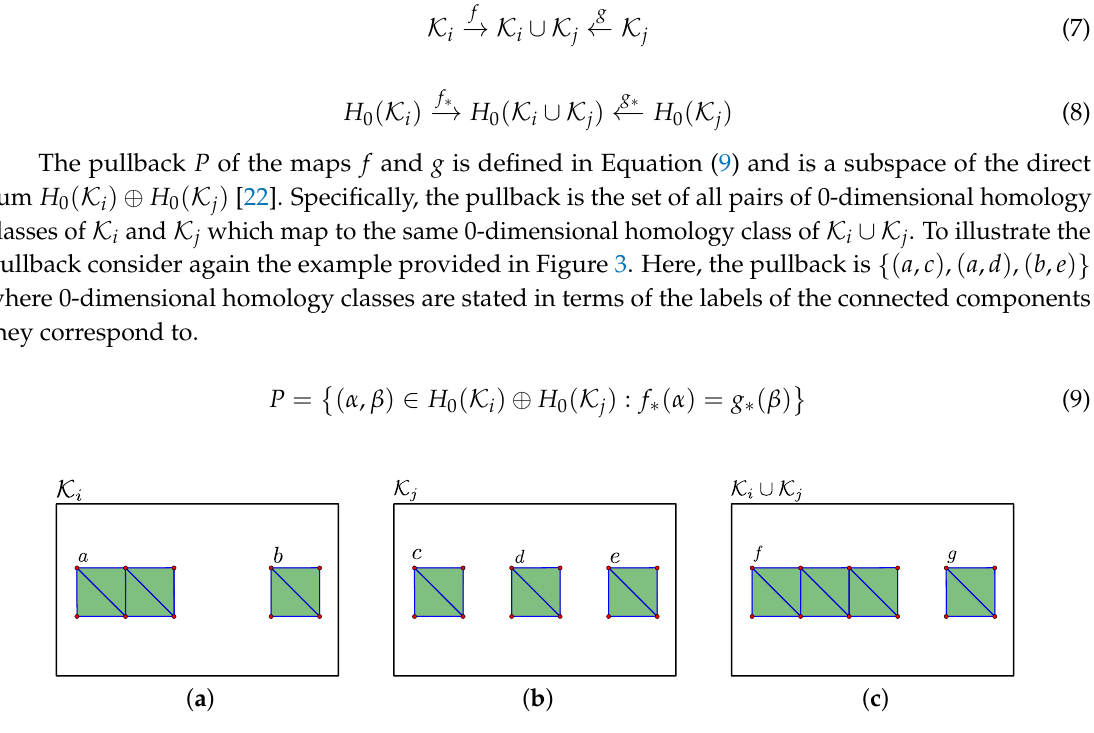
Figure 3. Two simplicial complexes K i and K j and their union K i ∪ K j are displayed in ( a – c ), respectively. Red dots represent 0-simplices, blue lines represent 1-simplices and green triangles represent